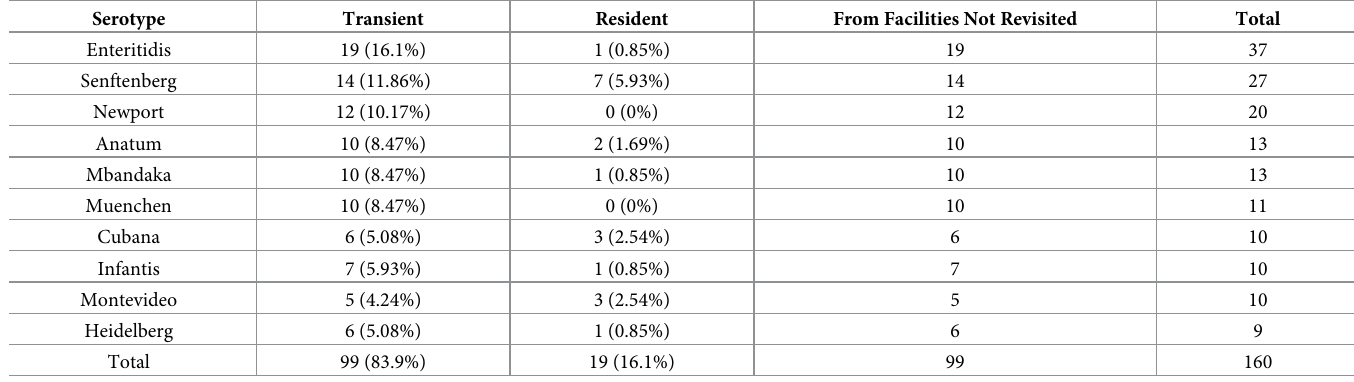
Table 3. Distribution and classification (i.e., resident, transient, or not revisited) of strains from the 10 most abundant Salmonella serotype detected. Percentages are relative to the total number of Transient and Resident strains.